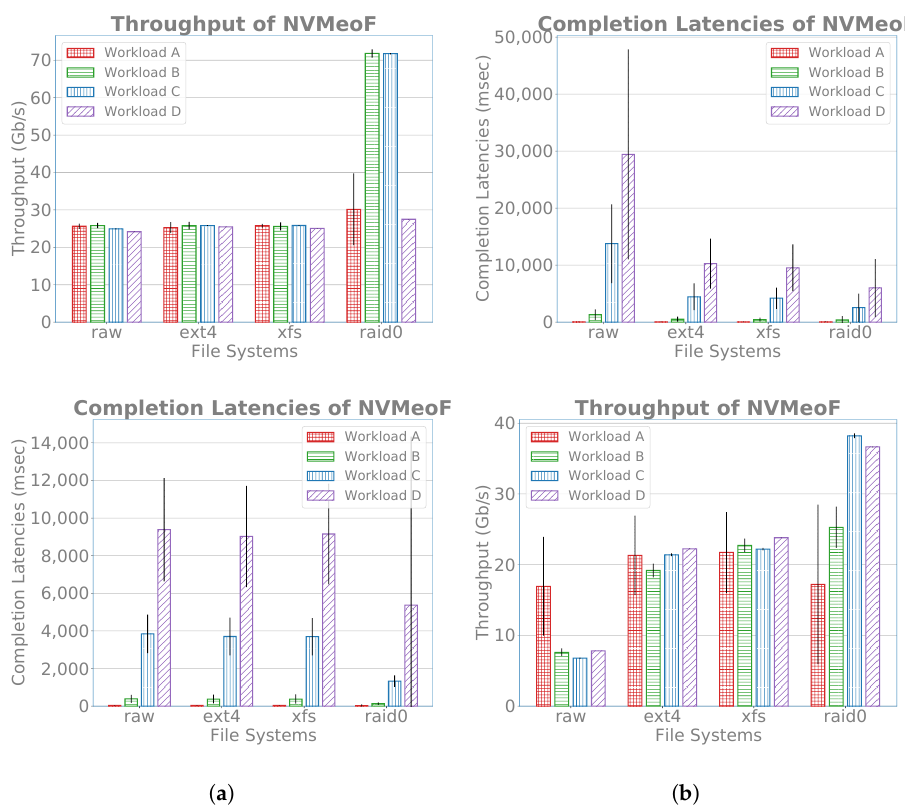
Figure 4. Average and standard deviation of read ( a ) and write ( b ) performance for UIC DTN using 16 KB inline data